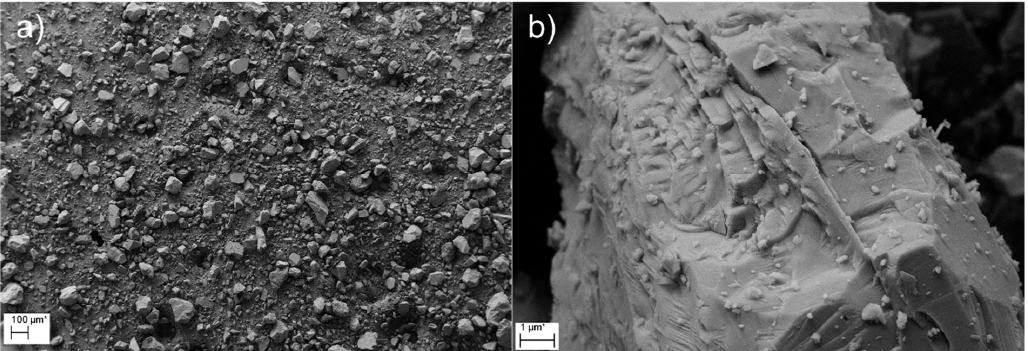
Figure 2. SEM images of the dolomite. Scale bars: ( a ) 100 µm; and ( b ) 1 µm.